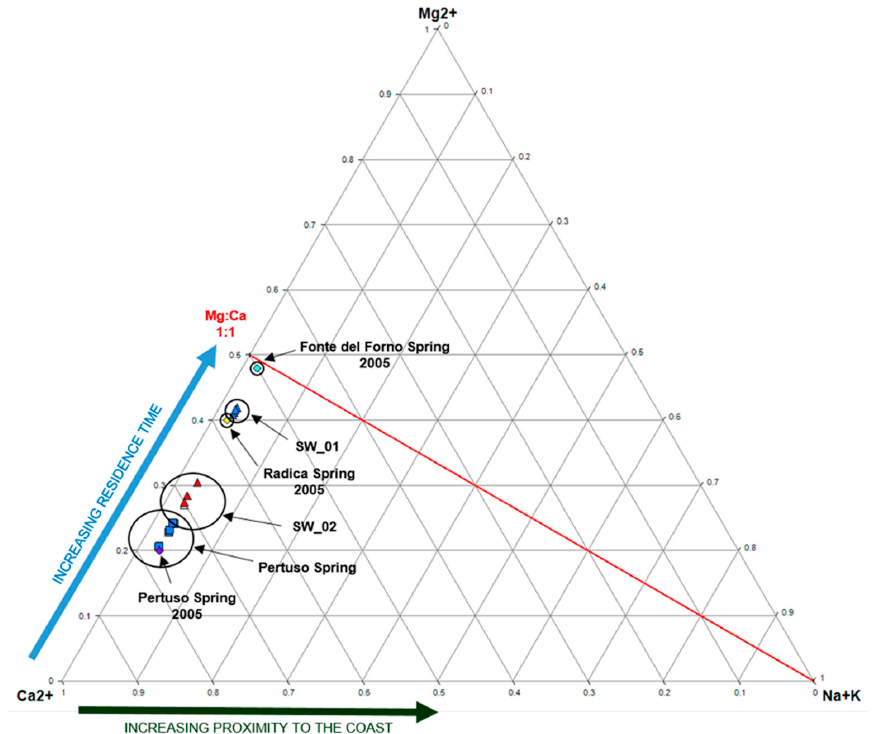
Figure 5. Ternary diagram of cations Ca 2+ , Mg 2+ , and Na + + K + . Relative concentrations of dissolved major cations compared with the composition of local groundwater [41].